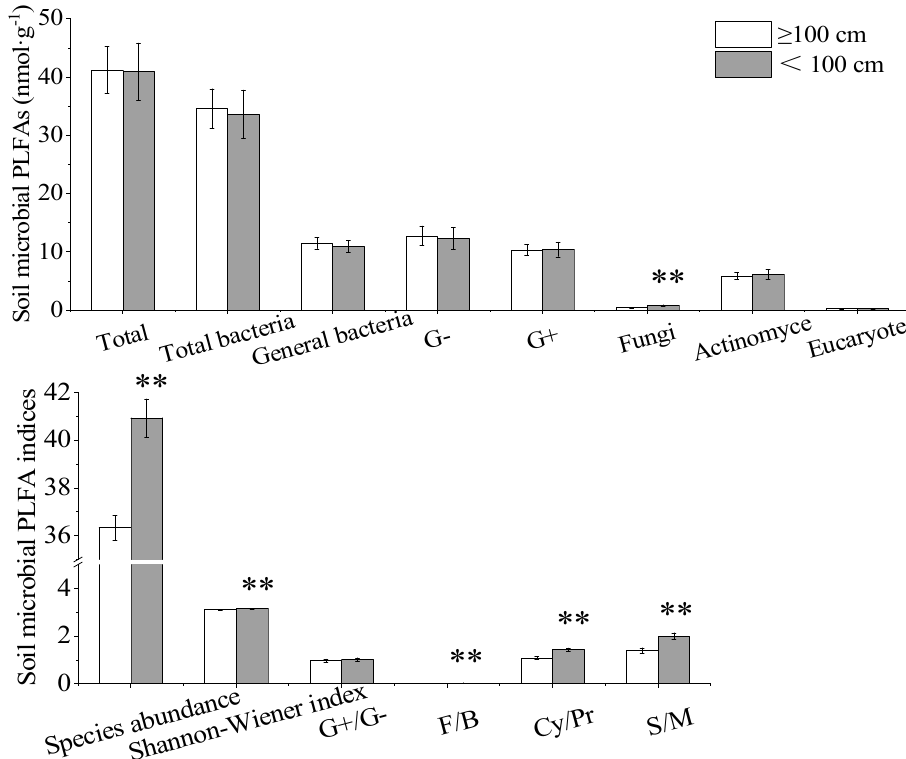
Figure 2. Soil microbial biomass and community structure indices for the two soil depth community categories. ** indicates significant difference at p < 0.01 level. Note—G+: Gram–positive bacte- rial PLFA; G − : Gram–negative bacterial PLFA; F: fungal PLFA; B: total bacterial PLFA, the sum of general bacterial PLFA, G+ and G − ; Cy/Pr: ratio of cyclopropyl/precursors as calculated by (cy17:0 + cy19:0)/(16:1 ω 7 + 18:1 ω 7); S/M: ratio of saturated PLFA to monounsaturated PLFA. For the same parameter, histograms show the mean with SD bar, n = 30 in soil depth <100 cm community and n = 33 in soil depth ≥ 100 cm community ** indicates significant difference at p < 0.01 level. The same definitions apply below.